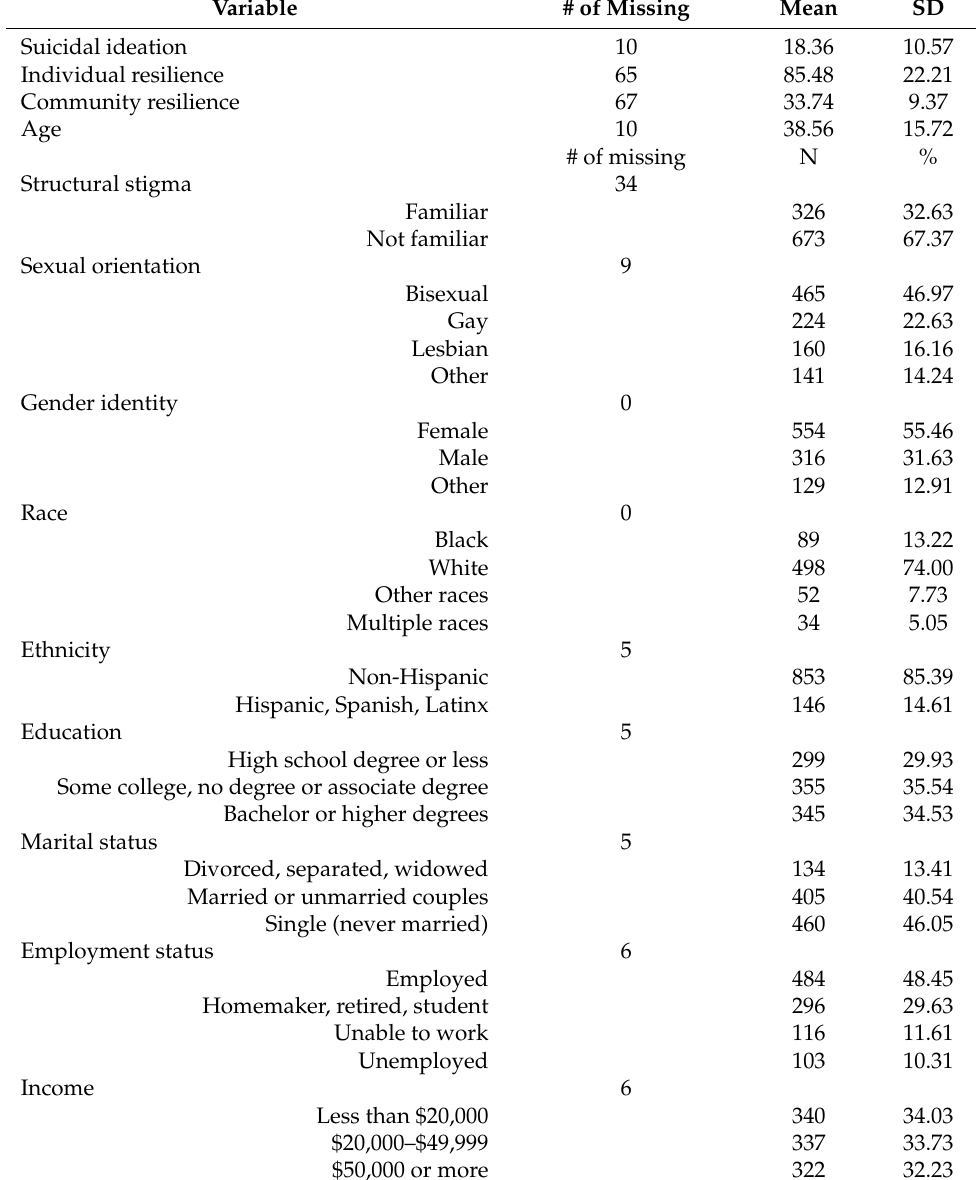
Table 1. Sample characteristics for main predictor, moderators, covariates, and